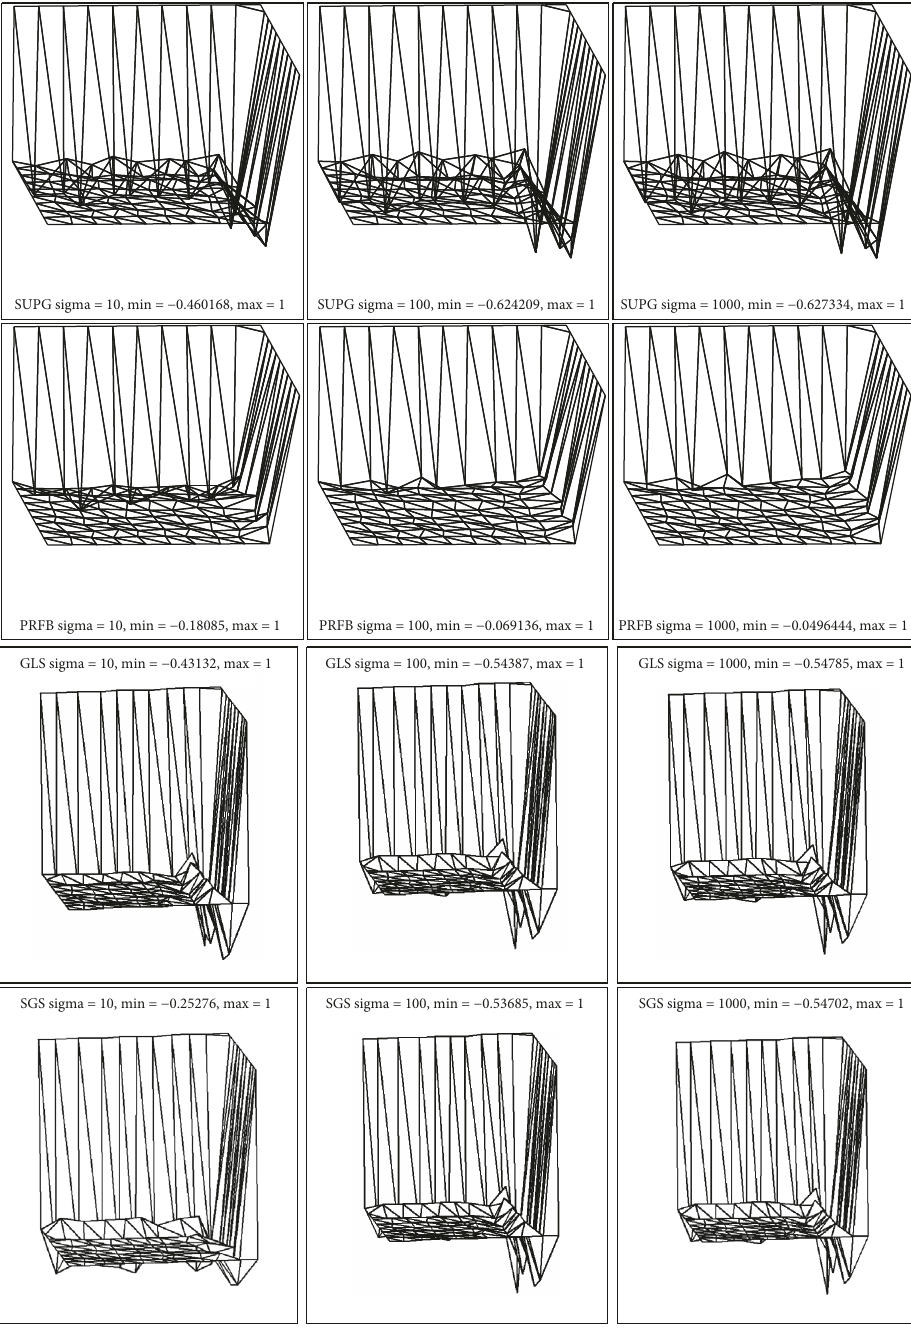
Figure 15: Numerical solution for 𝜖 = 10 −4 (top to bottom: SUPG, P-RFB, GLS, and SGS; left to right: 𝜎 = 10, 10 2 ,10 3 ).